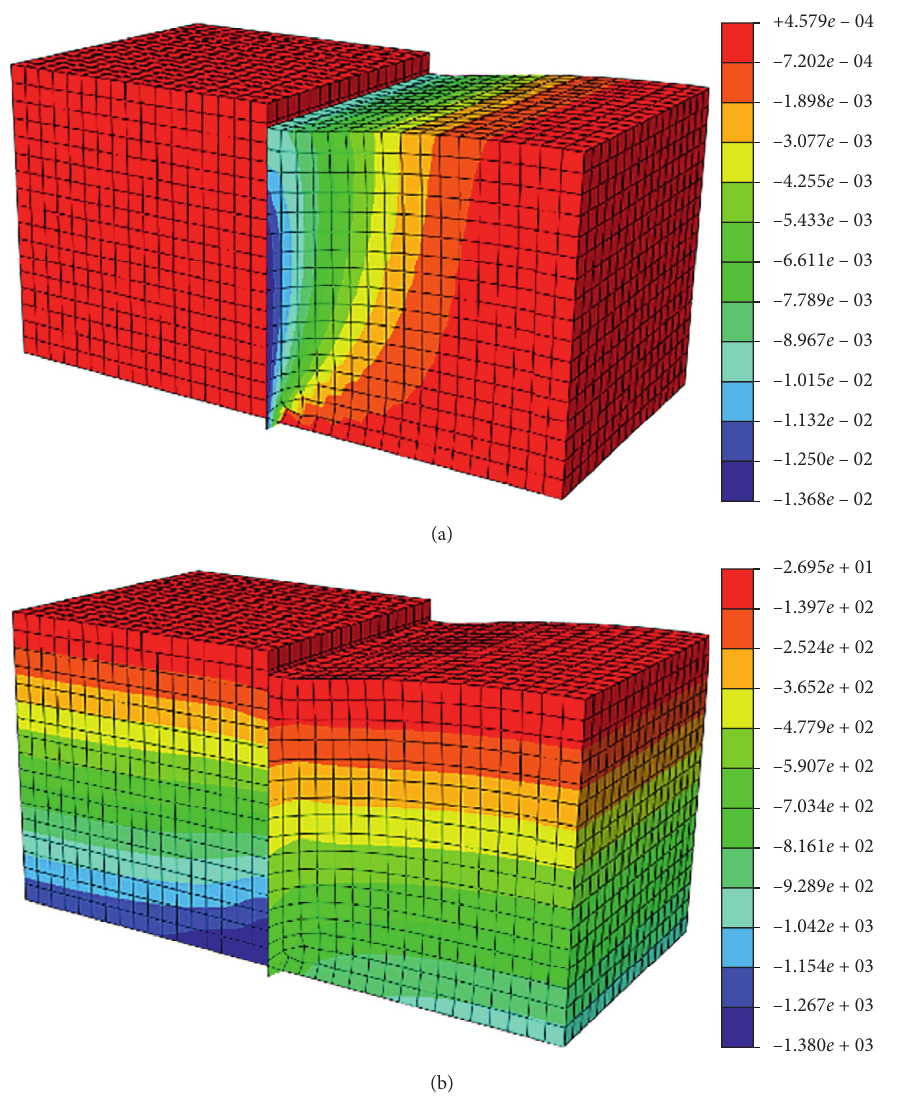
Figure 10: Simulation results of method C. (a) Displacement results (unit: m) and (b) vertical stress results (unit: